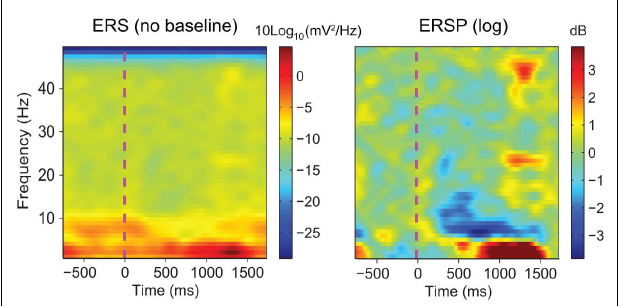
FIGURE 1 | Raw event-related spectrum (absolute log-ERS) on the left versus baseline corrected ERSP (log-ERSP) on the right for scalp EEG data trials. Electrode Iz from the “animal” dataset of subject “CLM” (see Materials and Methods) was used to compute FFT-based ERS and ERSP. ERS was computed using Eq. 1 and log-ERSP was computed using the classical baseline correction divisive method described in Eq. 6 (see Materials and Methods). Although post-stimulus power decrease at about 7Hz is clearly visible on the ERSP image, it is more difficult to see in the ERS image where large low-frequency changes stretch the color scale limits.This shows the usefulness of removing the pre-stimulus baseline for scalp EEG